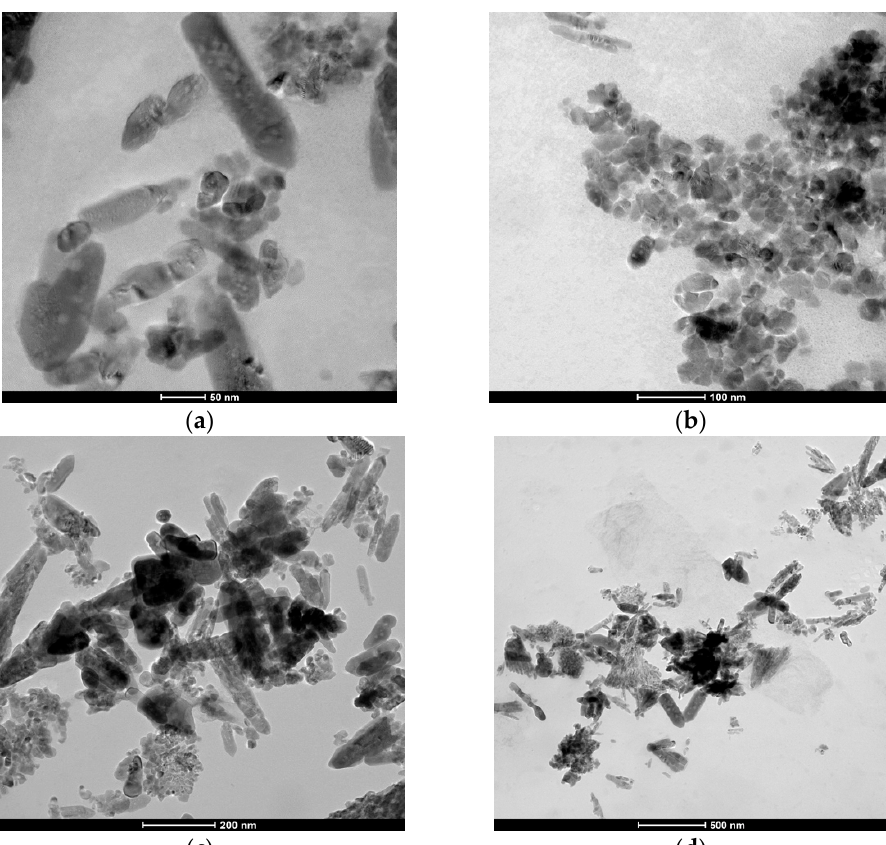
Figure 6. TEM images for ZnO nanoparticles, ( a ) scale bar 50 nm, ( b ) scale bar 100 nm, ( c ) scale bar 200 nm, ( d ) scale bar 500 nm.